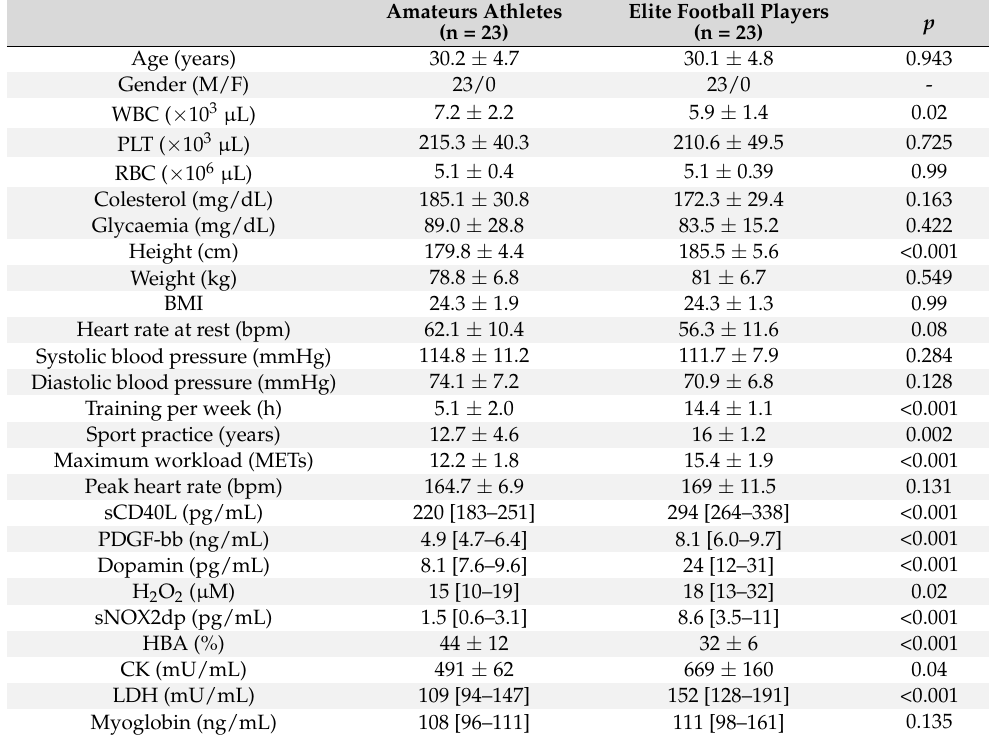
Table 1. Baseline characteristics of Amateurs and elite football